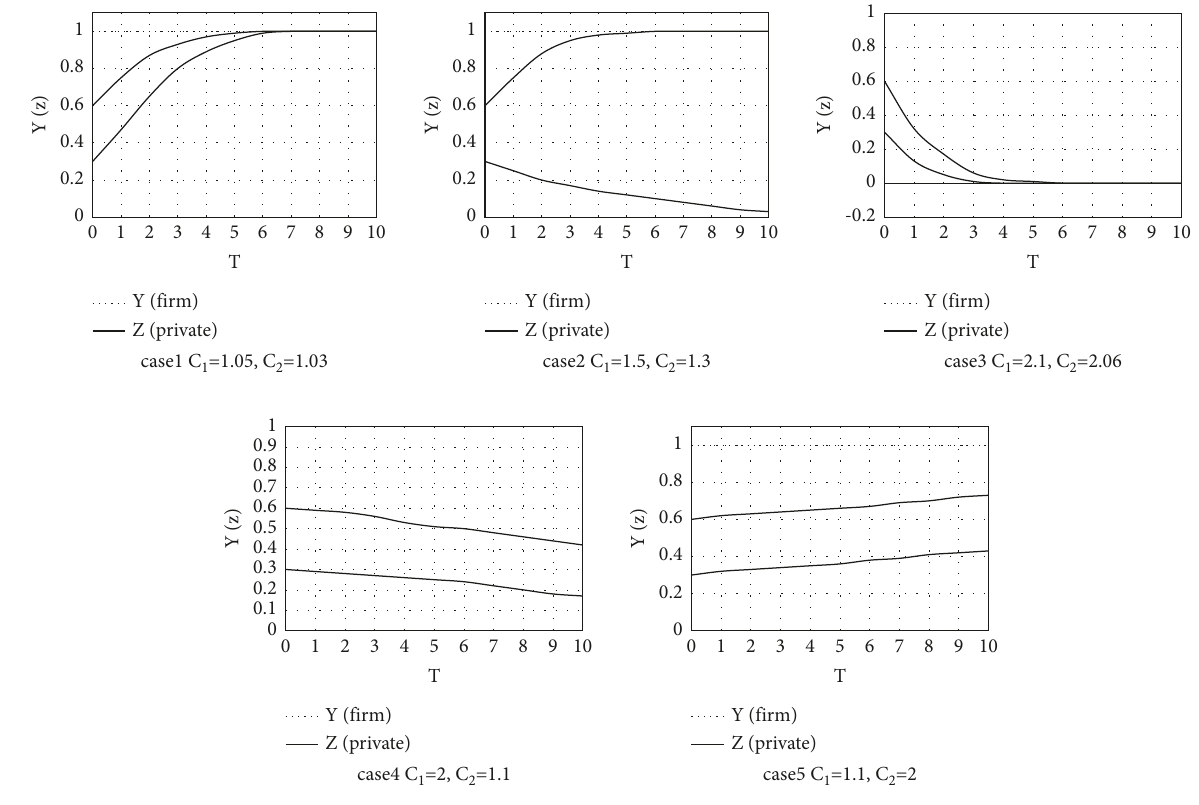
Figure 6: C C 1 , 2 impact of changes on the evolution of co-created value.